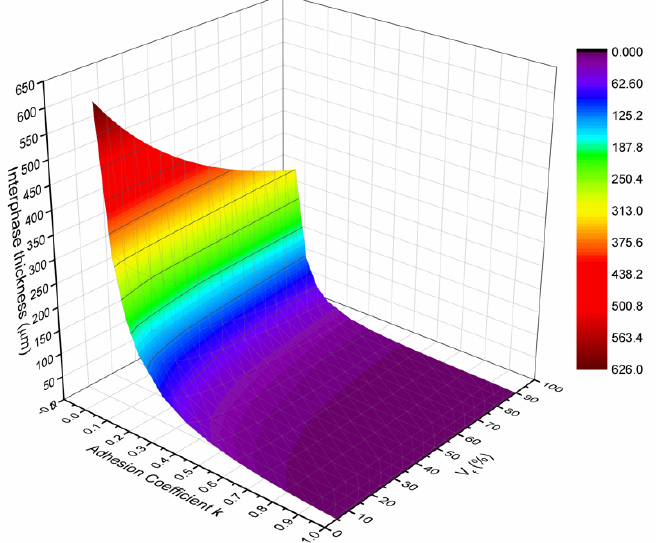
Figure 4. Prediction of the interphase thickness ∆ r i as a fraction of the volume fraction V f and the adhesion coefficient k E .